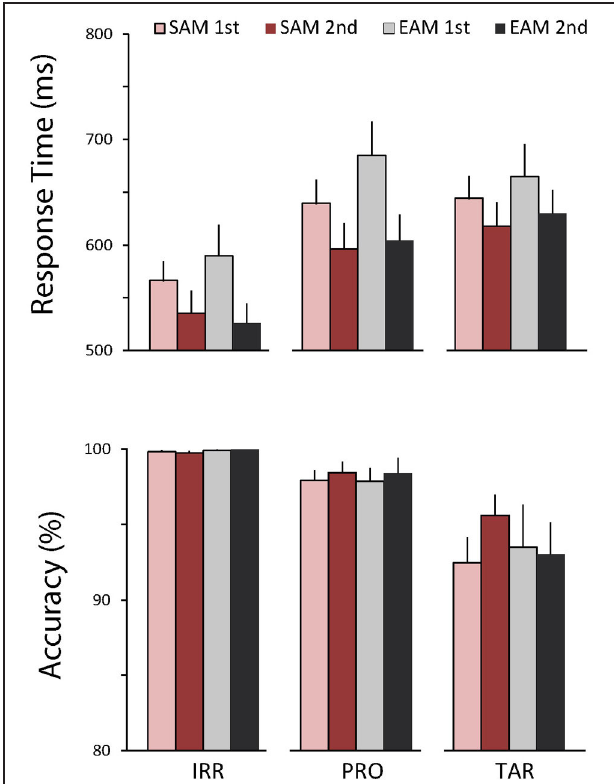
FIGURE 2 | Behavioral results. Top, average response times (RTs) to irrelevants, probes, and targets in the semantic (red bars) and episodic (gray bars) autobiographical conditions during the first (light bars) and second (dark bars) repetition. Bottom, accuracy for the same conditions. Error bars depict 1